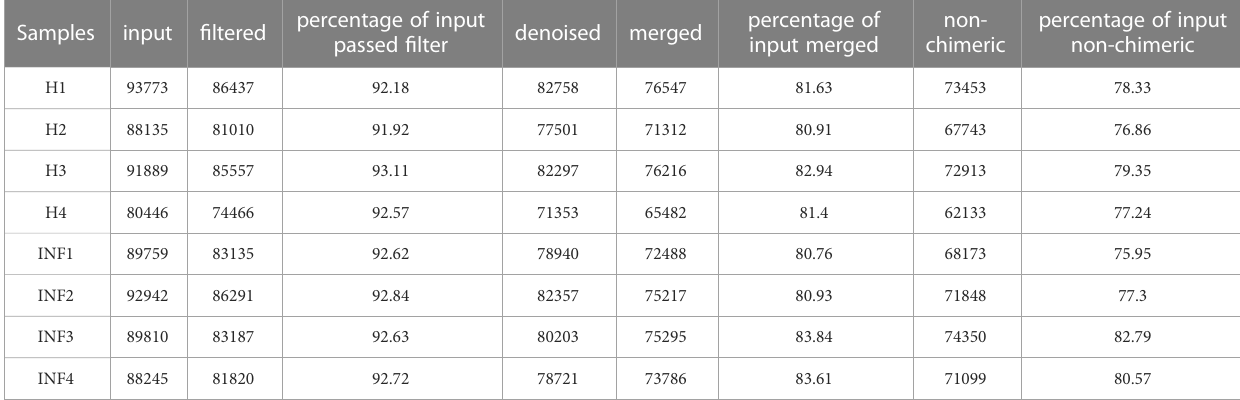
TABLE 1 The sequence data statistic